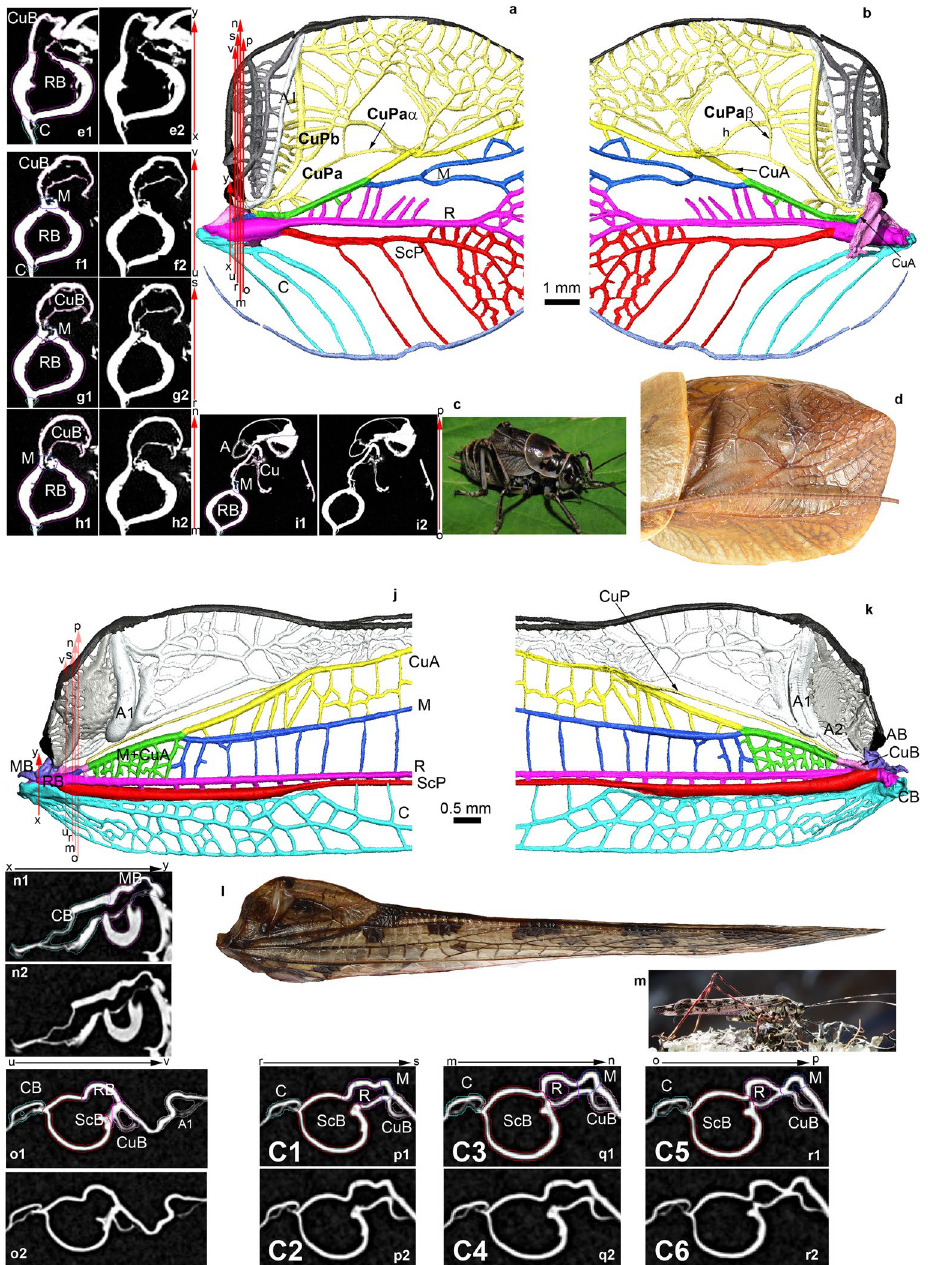
Figure 3. Wing venation interpretations. ( a – i ) Prophalangopsidae ( Cyphoderris monstrosa ). ( a ) 3D modeling of wing venation using XMT, view from above. ( b ) 3D modeling of wing venation using XMT, view from below. ( c ) General habitus (copyright and thanks to D. Gwynne for authorization to use). ( d ) Complete tegmen (copyright L. Desutter-Grandcolas). ( e ) Cut xy (1 colored; 2 without color; orientation of tomogram plane XY, tomogram number 1159). ( f ) Cut uv (1 colored; 2 without color; orientation of tomogram plane XY, tomogram number 1131). ( g ) Cut rs (1 colored; 2 without color; orientation of tomogram plane XY, tomogram number 1134). ( h ) Cut mn (1 colored; 2 without color; orientation of tomogram plane XY, tomogram number 1138). ( i ) Cut op (1 colored; 2 without color; orientation of tomogram plane XY, tomogram number 1112). ( j–o ) Tettigonioidea ( Quiva sp.). ( j ) 3D modeling of wing venation using XMT, view from above. ( k ) 3D modeling of wing venation using XMT, view from below. ( l ) General habitus (copyright and thanks to P.S. Padron for authorization to use). ( m ) Complete tegmen (copyright L. Desutter-Grandcolas). ( n ) Cut xy (1 colored; 2 without color; orientation of tomogram plane XZ, tomogram number 130). ( o ) Cut uv (1 colored; 2 without color; orientation of tomogram plane XZ, tomogram number 207) ( p ) Cut rs (1 colored; 2 without color; orientation of tomogram plane XZ, tomogram number 223). ( q ) Cut mn (1 colored; 2 without color; orientation of tomogram plane XZ, tomogram number 232). ( r ) Cut op (1 colored; 2 without color; orientation of tomogram plane XZ, tomogram number 235). (3D XMT L.